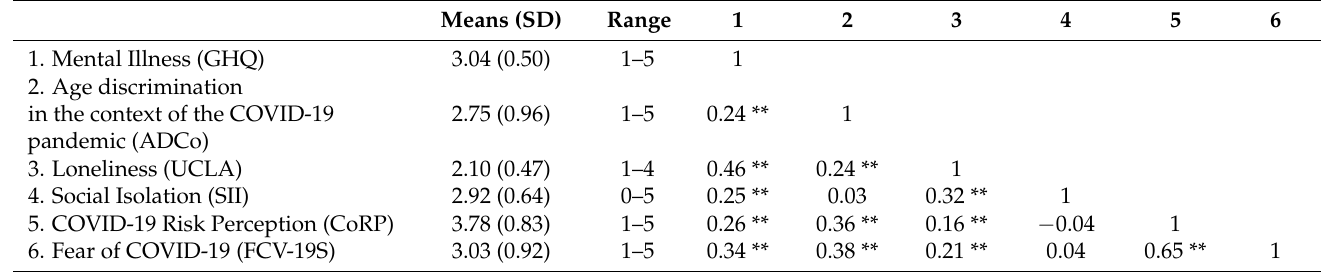
Table 4. Means, standard deviations and correlations between the variables included in the study.